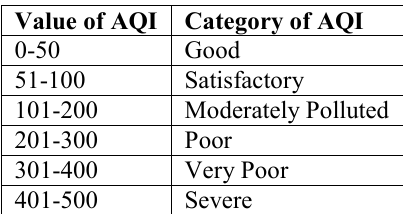
Table 1. National Air Quality Index